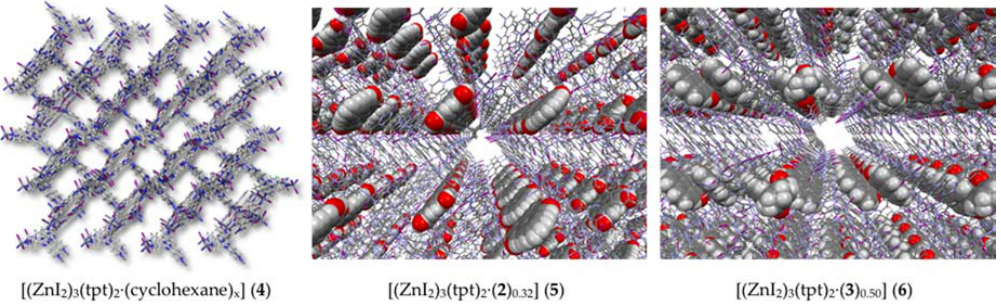
Figure 3. Crystal structure of the guest ‐ absorbed crystalline sponge.